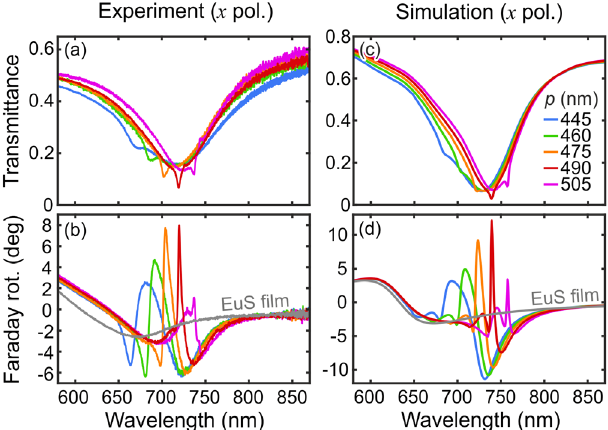
FIG. 3. The left-hand column displays the measured trans- mittance (a) and Faraday rotation (b) for x -polarized incident light for a wire width of 85 nm, burial parameter b ¼ 33 nm, and different grating periods. The experimental data agree with the performed simulation shown in the right-hand column (c),(d).